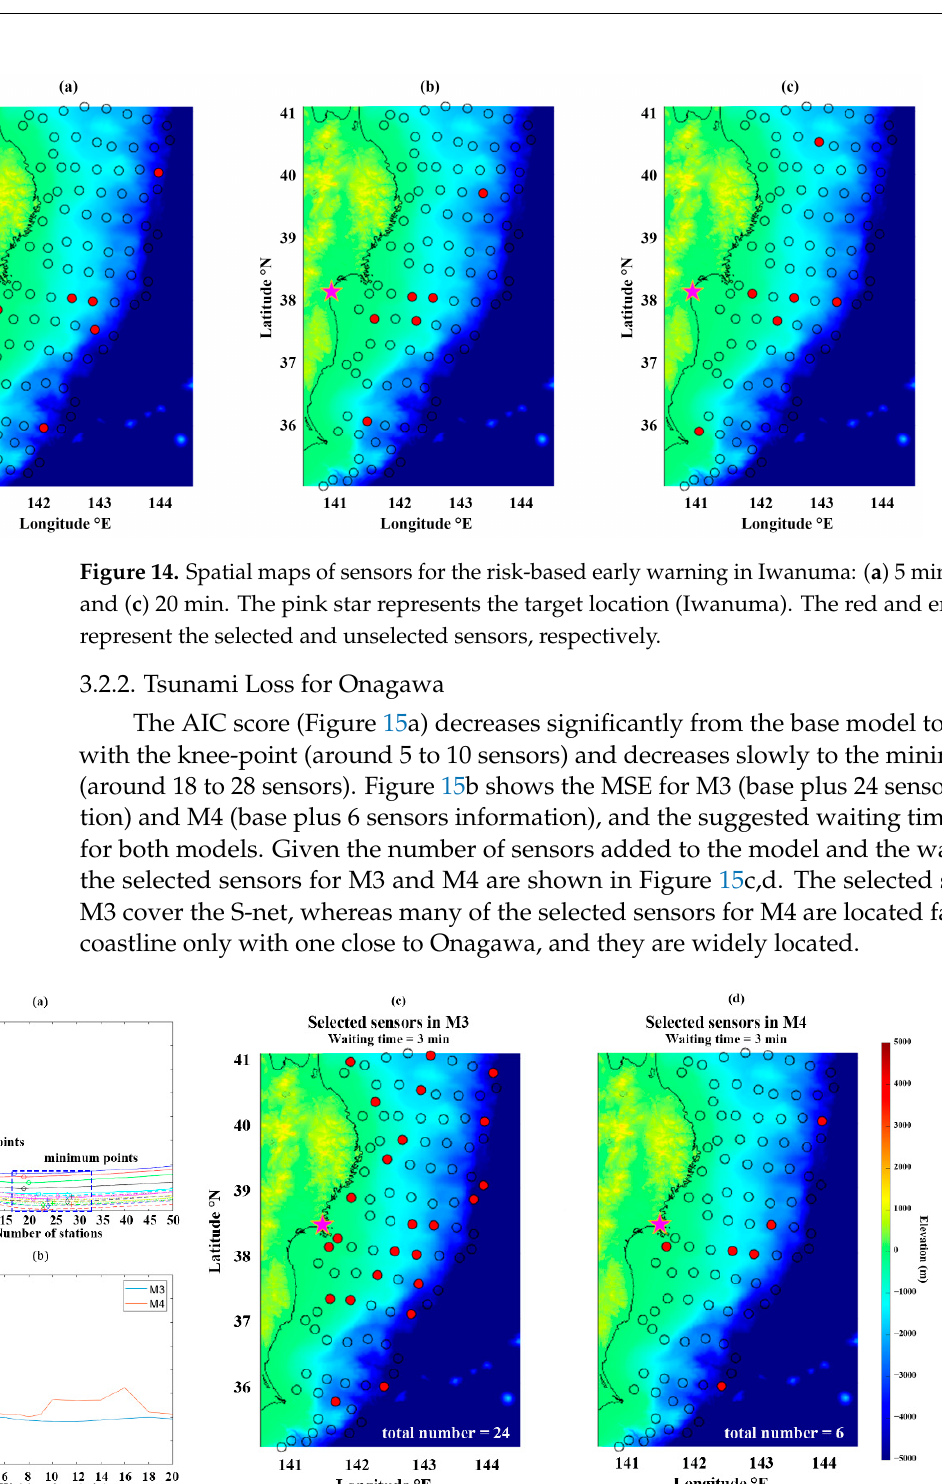
Figure 13. Results of the risk-based early warning model for Iwanuma: ( a ) AIC score plot, ( b ) MSE- waiting time plot, ( c ) optimal sensor map for M3, and ( d ) optimal sensor map for M4. The pink star represents the target location (Iwanuma). The red and empty circles represent the selected and un- selected sensors, respectively.